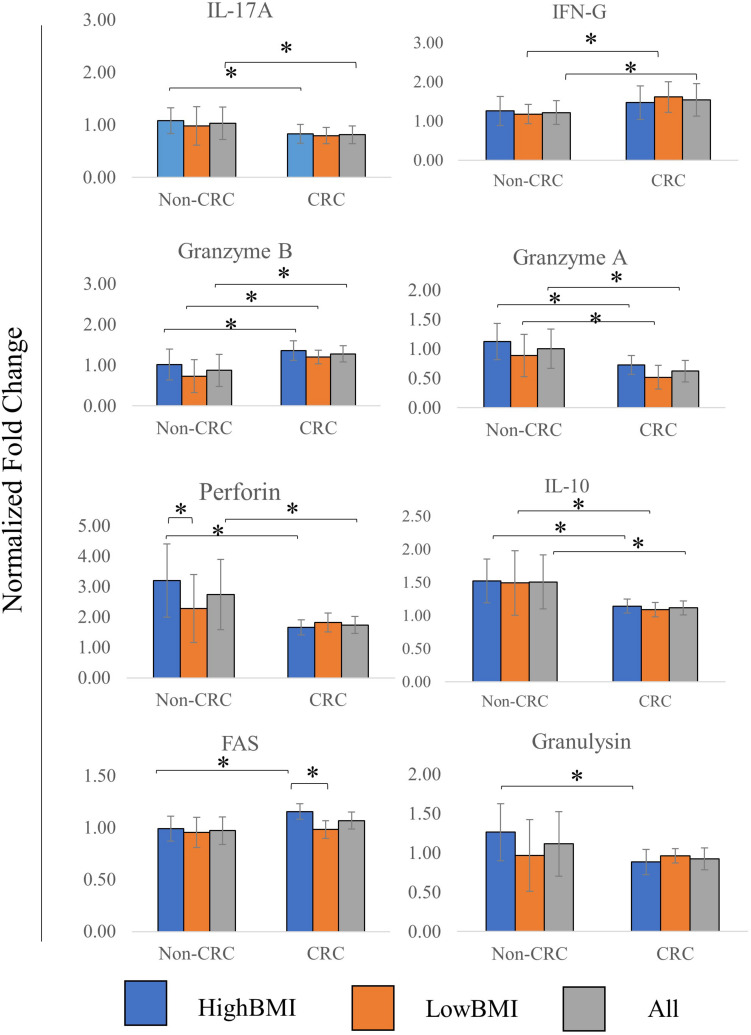
Normalized fold change ± SD of the secreted cytokines analyzed using multiparametric flow cytometry for each group. Experimental values were normalized against cytokines released from untreated T cells. The “All” group is the combination of CRC and Non-CRC regardless of BMI status (n = 8, for each group). ANOVA analysis was performed for each of the cytokines and statistical significance was set at p < 0.05. * indicates statistical significance at p < 0.05.